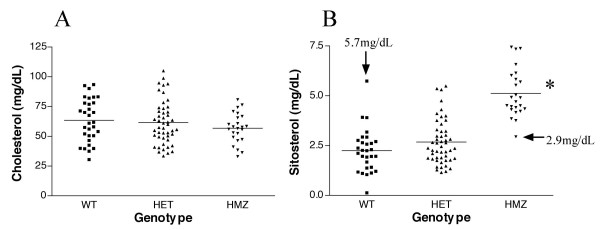
Plasma sterols as a function of Abcg5 genotypes. Cholesterol (panel A) and sitosterol (panel B) were segregated in all F2 animals by Abcg5 Gly583Cys. While there were no differences between cholesterol values between any of the genotypes, F2 rats who were homozygous for Cys583 (HMZ) showed significantly higher plasma sitosterol values (*, P < 0.05, mean 5.12 ± 0.25 mg/dl) compared to either heterozygous animals (HET, mean 2.68 ± 0.16 mg/dl) or wild-type (WT, mean 2.25 ± 0.20 mg/dl). These data were analyzed with the inclusion of two 'outliers' (arrows), one in the WT group and one in the HMZ group, where re-analyses to confirm these values were not possible (see Text).